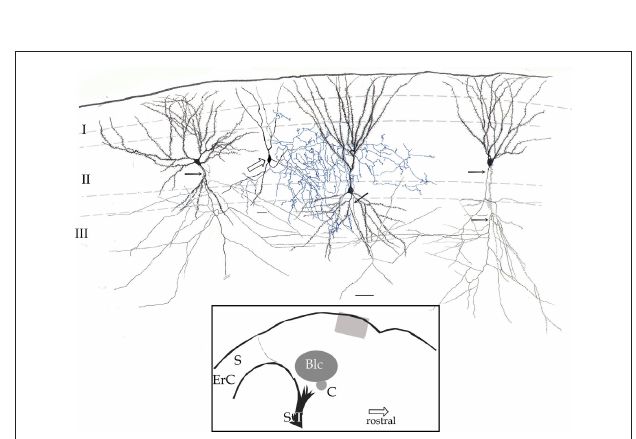
Figure 1 | Survey camera lucida drawings of the cytological organization and layering of the adult mouse piriform cortex and adjacent areas. (A) Transversal section. aIA, agranular insular area; CoApl, cortical anterior nucleus of the amygdala, posterolateral part; PC, piriform cortex; TrAP, Transitional amygdalo-piriform cortex. Golgi-Cox impregnation. (B) Longitudinal section through the piriform and periamygdaloid cortices. LOT, lateral olfactory tract; arrow = caudal border of the lateral olfactory tract. Scale bars = 1 mm in (A) ; 200 in (B) .